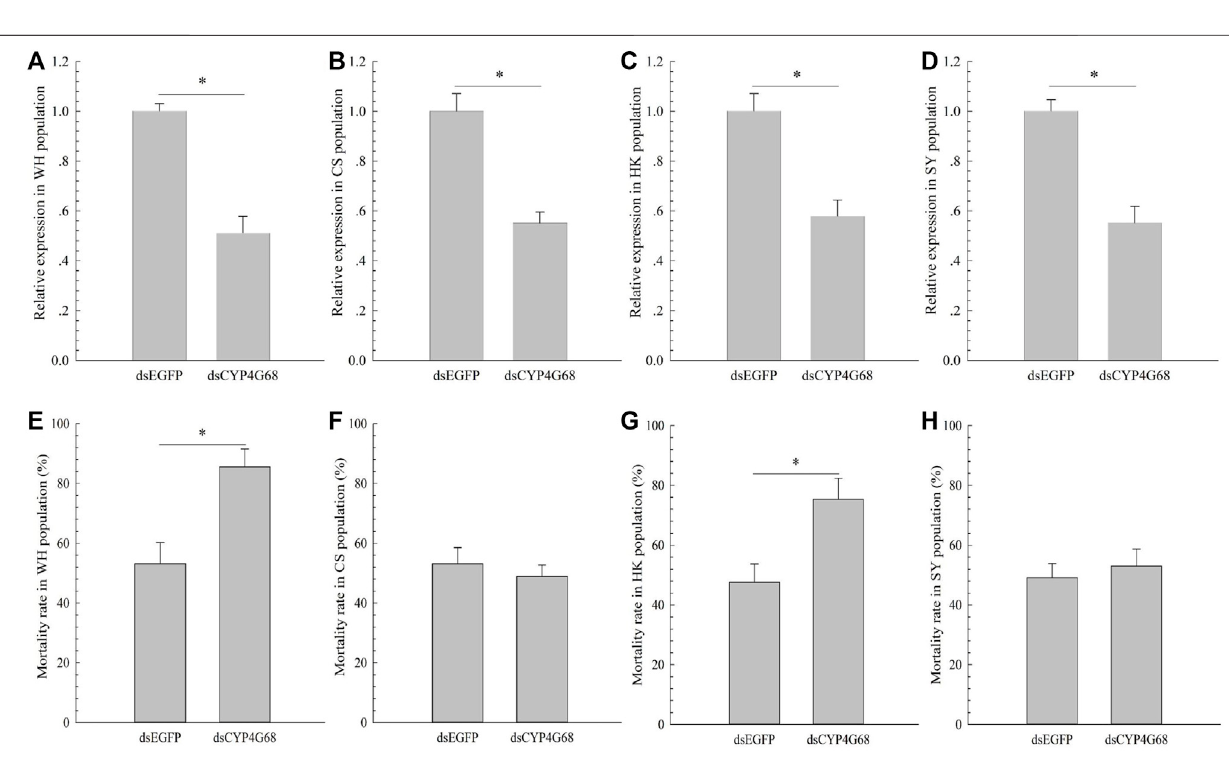
Frontiers in Environmental Science |